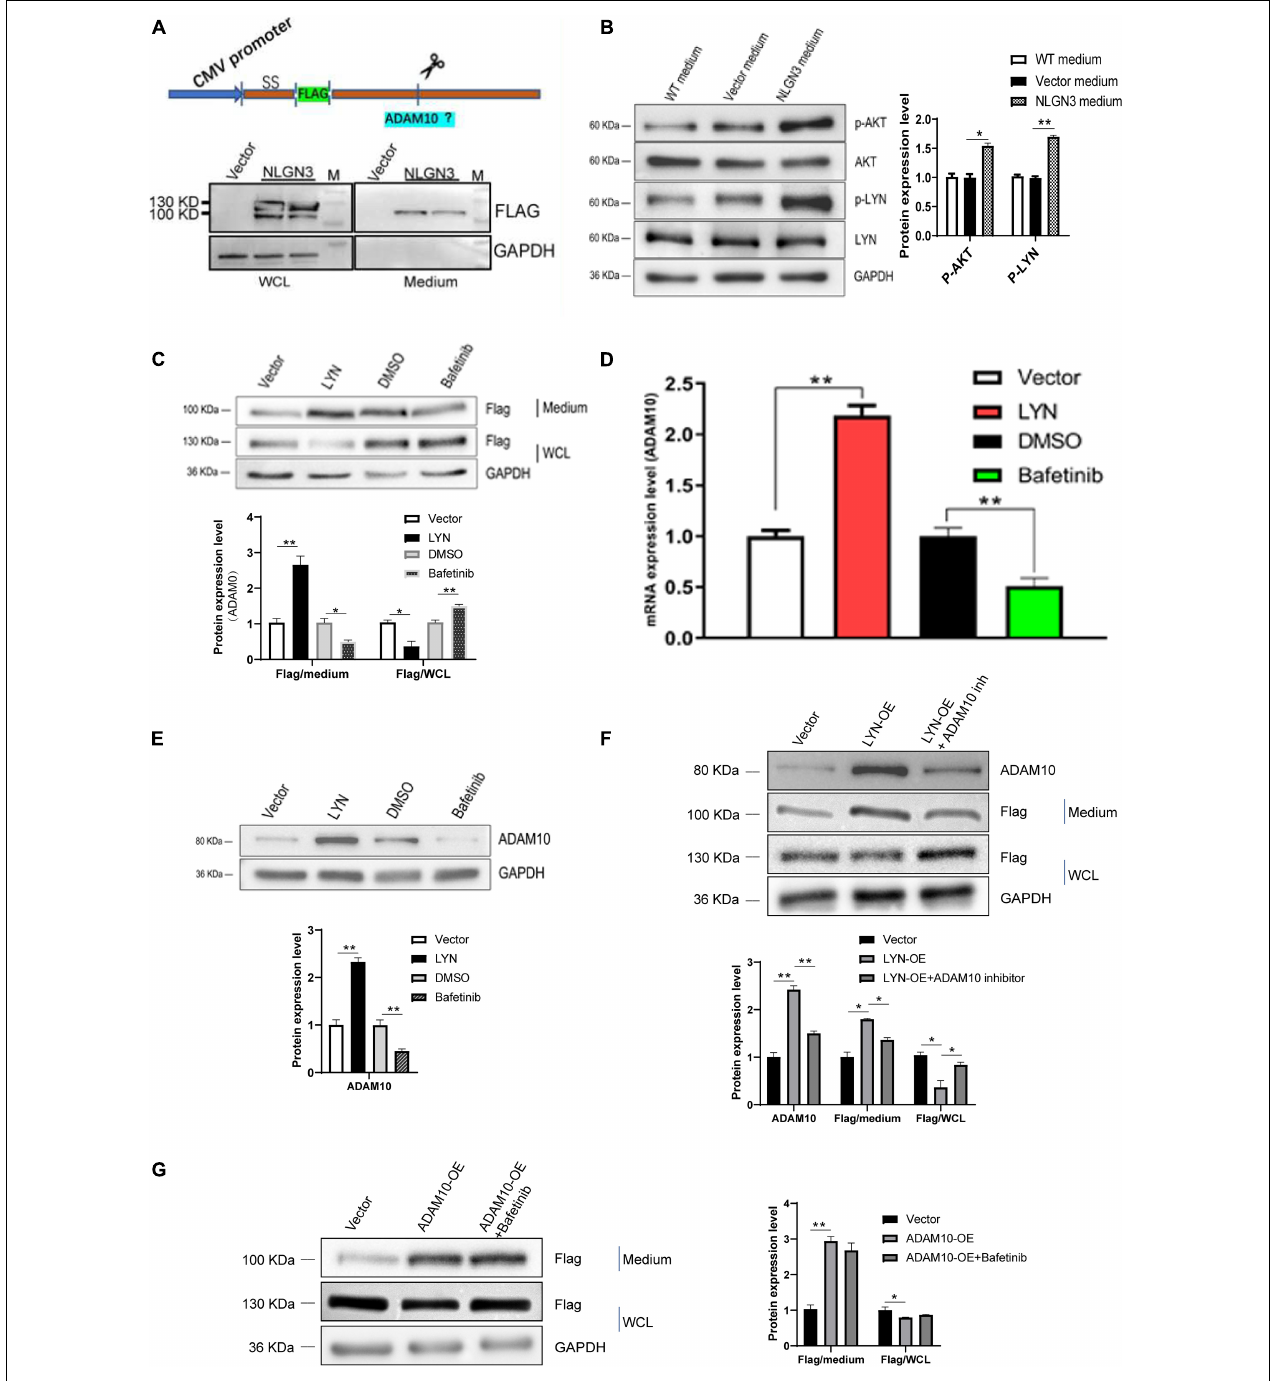
FIGURE 4 | NLGN3 activated the LYN pathway to upregulate ADAM10, which in turn promoted cleavage of NLGN3. (A) The NLGN3 plasmid carrying the Flag fragment was transfected into U251 cells with an empty vector as the control. Western blot was performed to detect the Flag label. SS = signal sequence; M = maker. (B) The level of phosphorylation of AKT and LYN was detected after treatment with a NLGN3 plasmid, with an empty vector as the control. WT = wild type. (C) U251 cells were transfected with LYN or treated with bafetinib along with NLGN3 plasmid transfection, with an empty vector or DMSO as the control. Western blot was performed to detect the Flag label. WCL = whole cell lysates. (D) qPCR was performed to detect the expression of ADAM10 in U251 cells. (E) Western blot was performed to detect the expression of ADAM10 in U251 cells. ADAM10 expression was upregulated by LYN and inhibited by bafetinib. (F) Compared with the control cells, LYN overexpression increased the level of cleaved NLGN3, whereas decreased cleaved NLGN3 was observed after treatment with the ADAM10 inhibitor compared with LYN overexpression cells. (G) Overexpression of ADAM10 increased cleaved NLGN3 levels, but there was no significant change of cleaved NLGN3 levels after treatment with LYN inhibitors compared with ADAM10 overexpression group. * p < 0.05; ** p < 0.01.